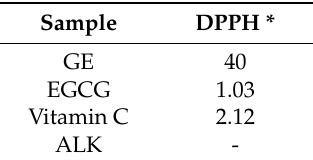
Table 2. In vitro antioxidant activity of GE as compared to the alkaloid extract from guarana (ALK) and standard natural